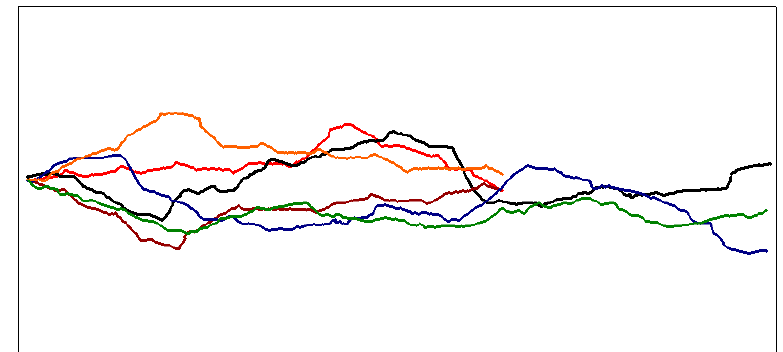
Figure 16. Generator of the fracture surface profile line for concrete of the content of MK = 8.5% relative to binder mass and w / b = 0.35—series 1 ( a ), w / b = 0.54—series 1 ( b ). Examples of model fractal profiles against the real profile lines are shown in Figures 17 and 18. The shorter lines denote the model lines.